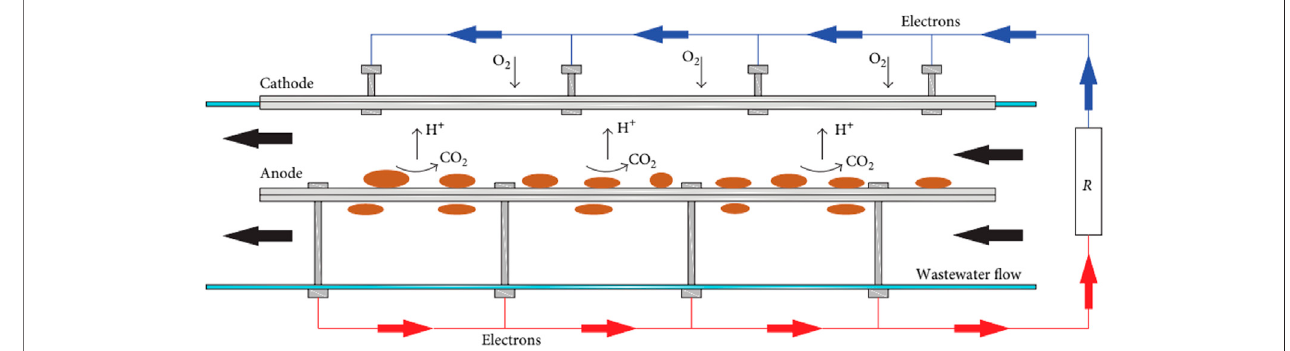
FIGURE 3 | Working principle of the MFC prototype (Capodaglio et al., 2013).